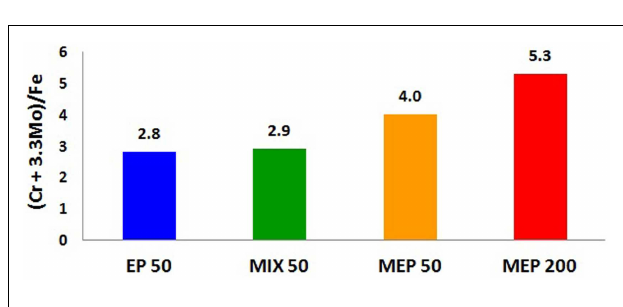
FIGURE 4 | XPS study results: changes in surface film composition of austeniticAISI 316L stainless steel after different electropolishing treatments: EP50, the process without stirring; MIX50, the process with a moderate electrolyte mixing; MEP50, magnetoelectropolishing at 50A/dm 2 ; MEP200, magnetoelectropolishing at 200A/dm 2 . polishing in a magnetic field MEP 200 ( Figure 4 ). The notations